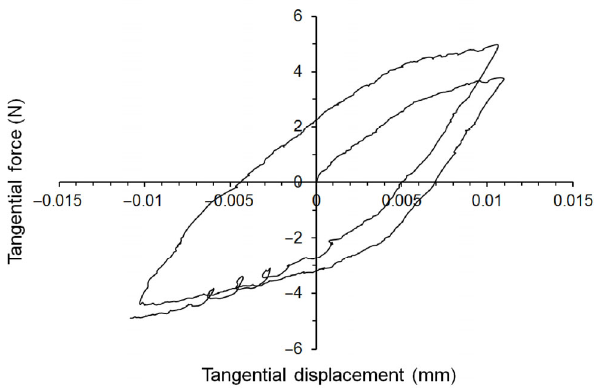
Fig. 17 A cyclic shearing test on crushed granitic granules at a normal force of 10